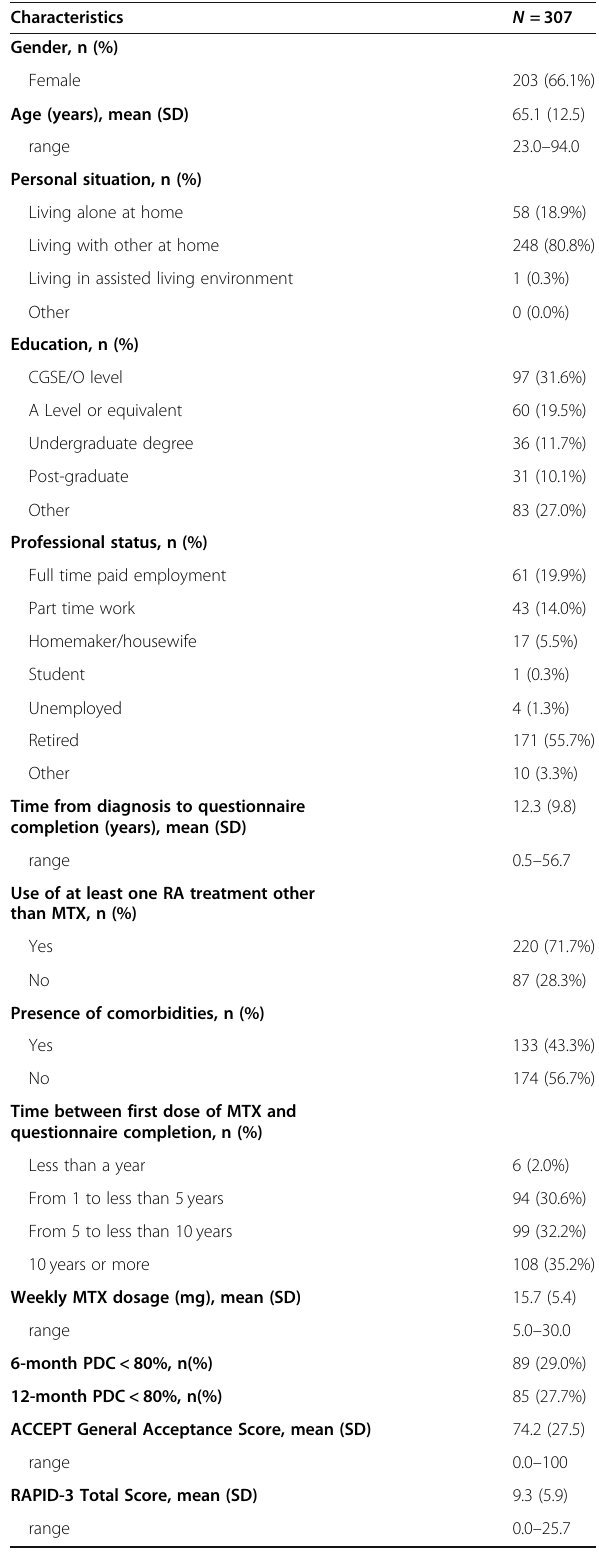
Table 1 Characteristics of the patients included in the psychometric validation